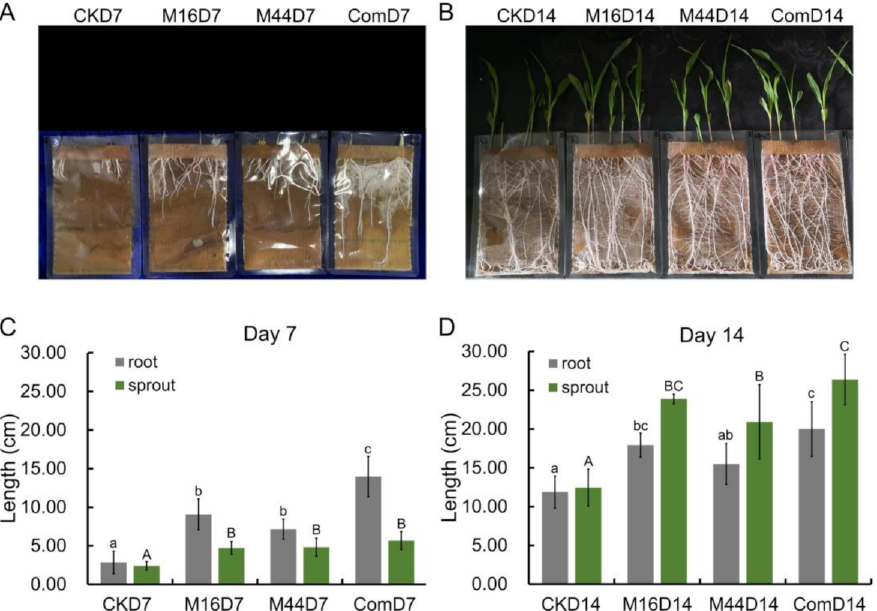
Figure 1. Maize germination for 14 days following microbial treatment. ( A ) Photograph showing root length at day 7 (D7). ( B ) Photograph showing root and sprout length at day 14 (D14). Bar graphs showing the root and sprout lengths at D7 ( C ) and D14 ( D ). CK: control; M16: M16 treatment; M44: M44 treatment; Com: combination of M16 and M44. Columns with the same lower (represent the comparisons of roots) and upper-case (represent the comparisons of sprouts) letters are not significantly different at the 5% level by DMRT,